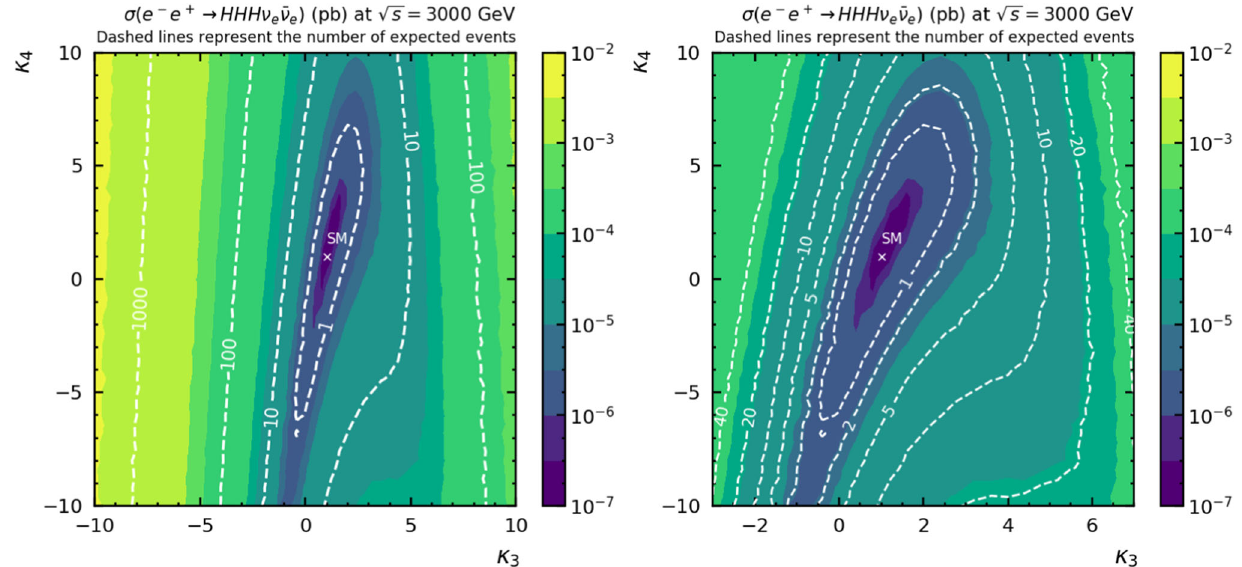
Fig. 36 Contour lines for the expected number of e + e − → b ¯ bb ¯ bb ¯ b ν e ¯ ν e events (white dashed lines) after applying all the cuts and efficiency factors, represented in the (κ 3 ,κ 4 ) plane. The corresponding